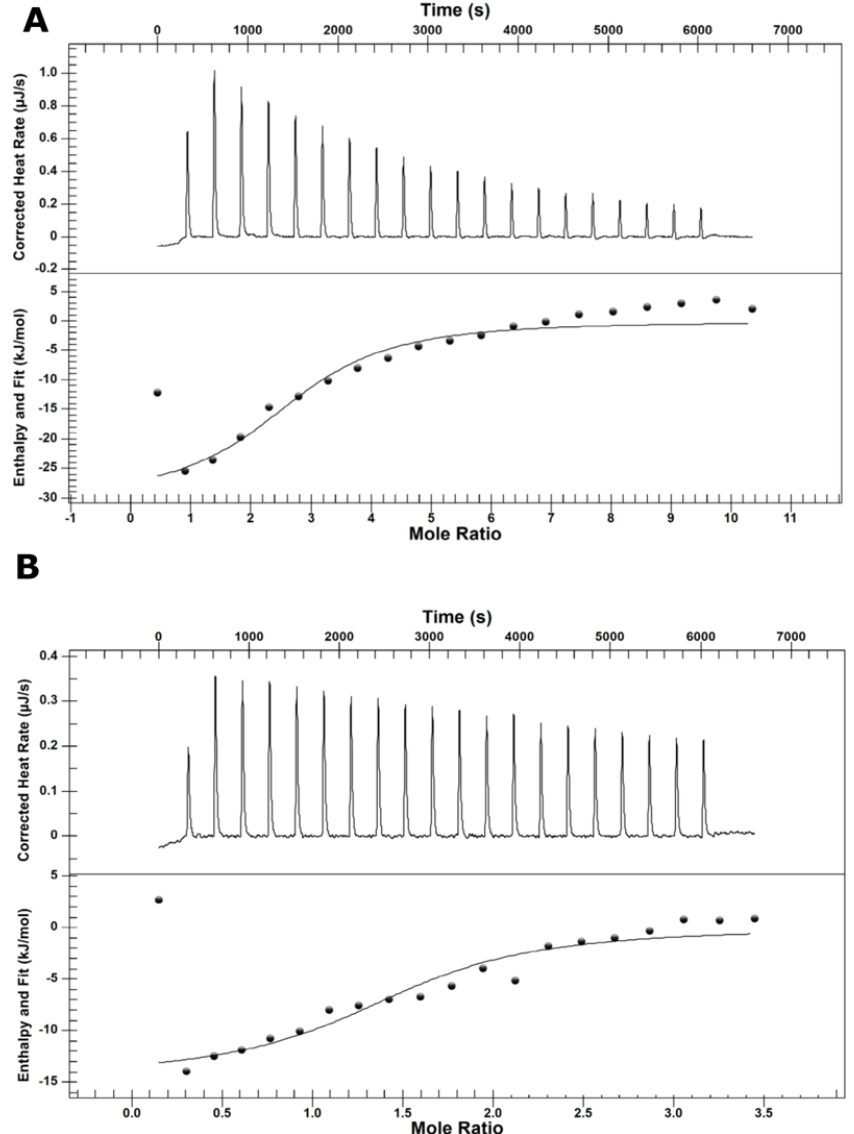
Figure 3. Binding isotherm curves of experimental calorimetric titrations of 0.3 mM L -malate ( − 2) ( A ) and ( − 1) ( B ) protonation states. Reaction was carried out by adding 30 mM malolactic enzyme to the reaction medium. Table 1. Binding energies ( ∆ G) of L -malate with malolactic enzyme using isothermal titration calorimetry.